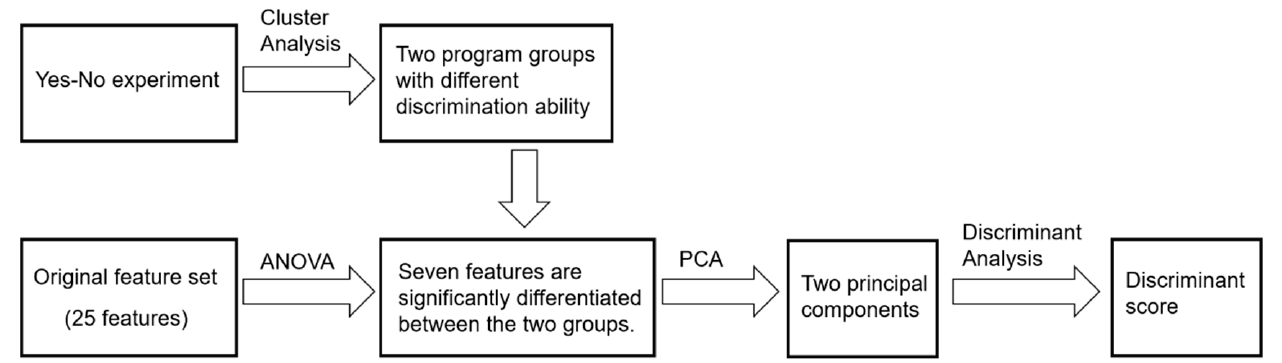
Figure 9. Schematic representation of the work methodology.